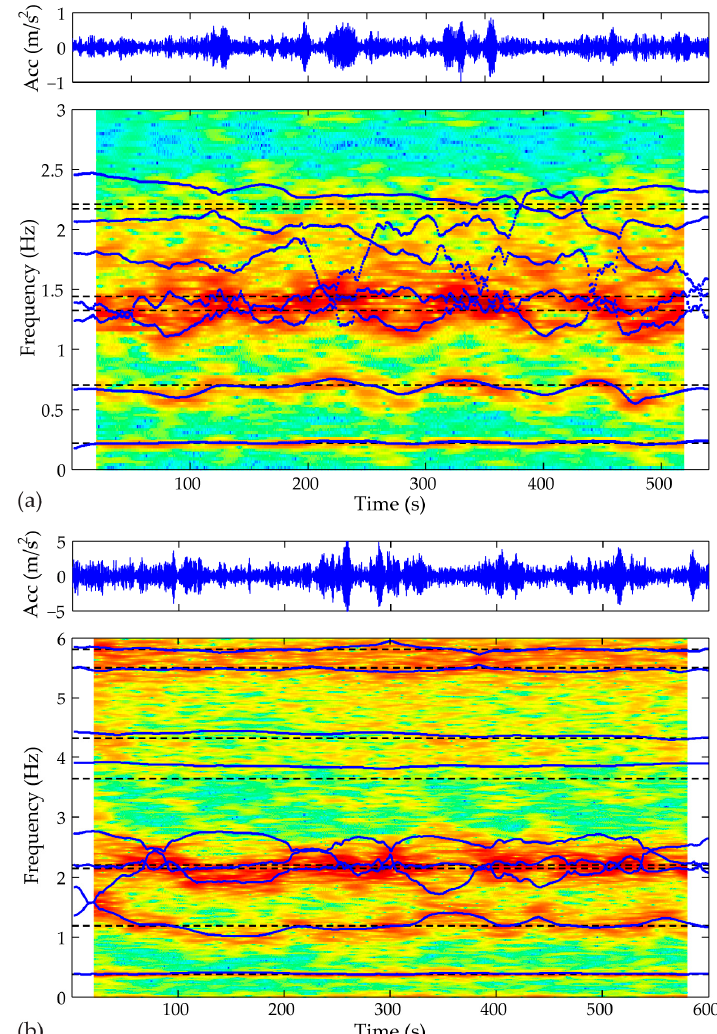
Figure 7. Dynamics of the WTs under normal operation: Stationary ARMA ( n a , n c ) versus nonstationary SP-TARMA ( n a , n c ) model estimates with spectrogram in the background (Short Time Fourier Transform; Hamming data window; NFFT = 512; overlap 98%). ( a ) Case A: ( n a , n c ) = (32, 32); ( b ) Case B: ( n a , n c ) = (18,